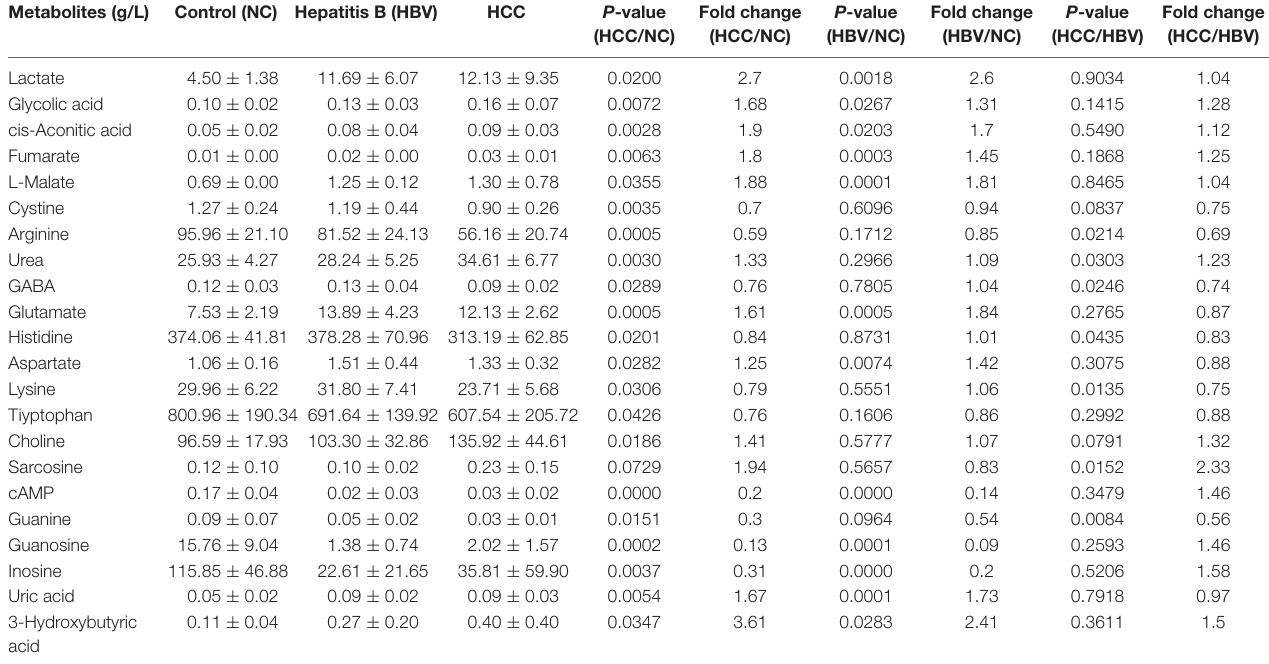
TABLE 1 | The main differential metabolites of HCC, hepatitis B patients and healthy controls by targeted metabolomics. Metabolites